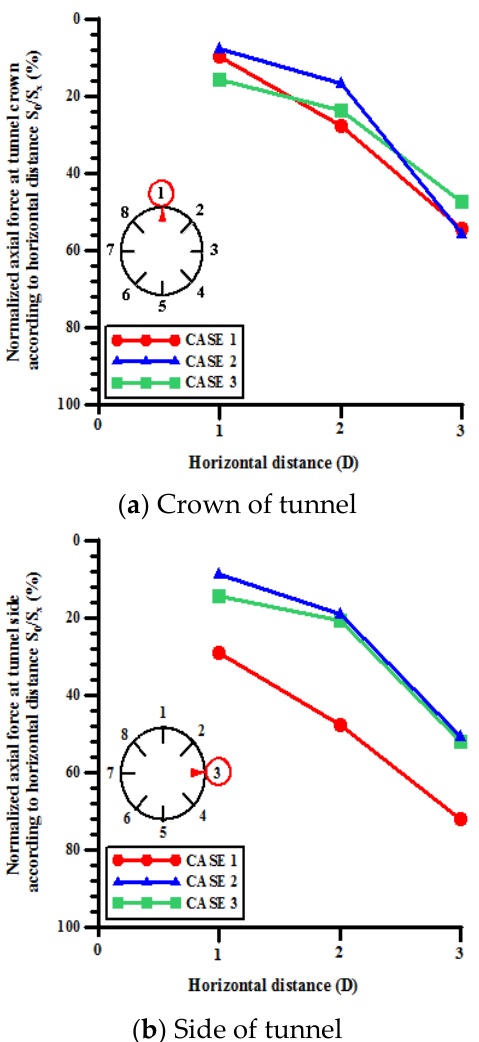
Figure 16. Normalized axial force by ultimate load according to horizontal offset.